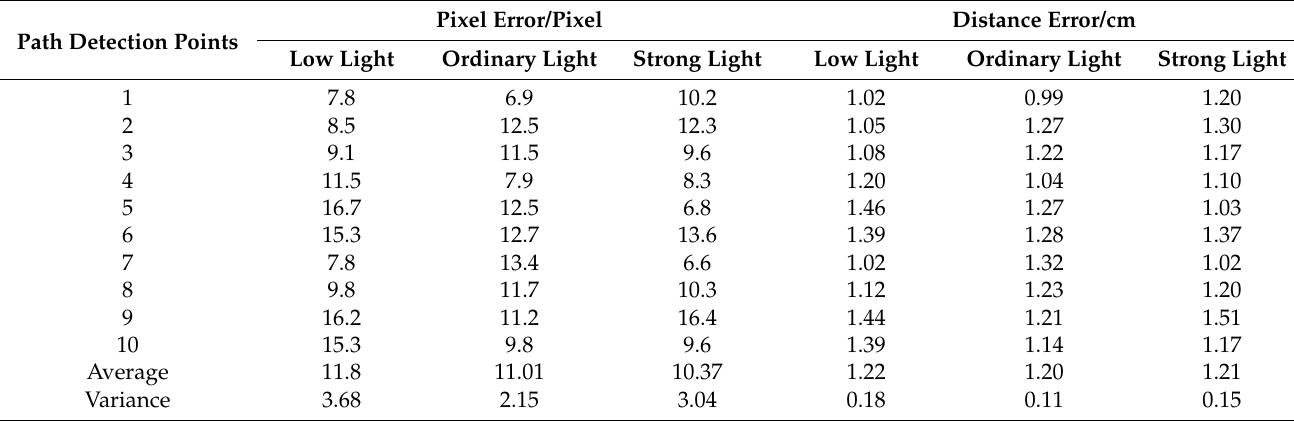
Table 5. The error values of the Unet